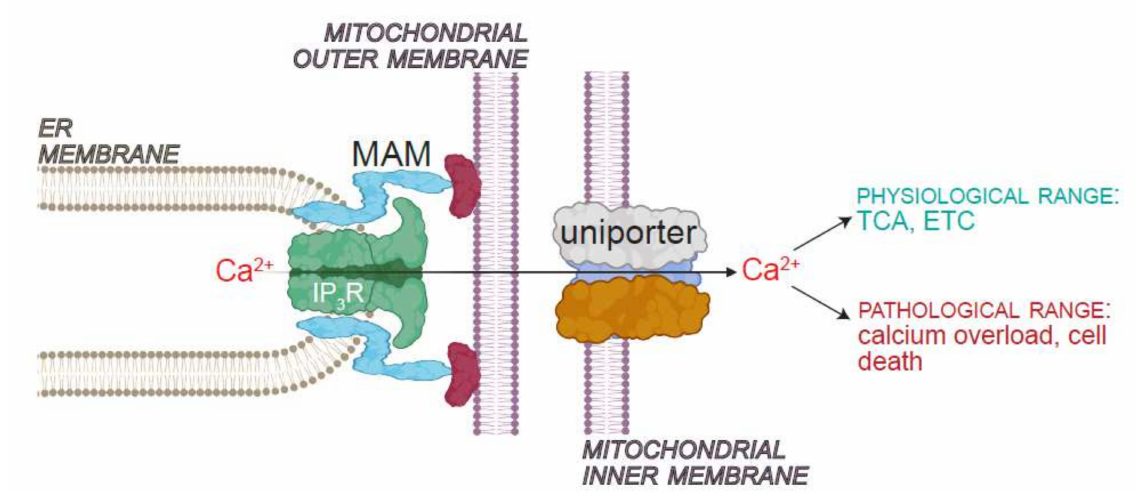
Figure 4. Interorganellar Ca 2+ transfer between ER and mitochondria. ER and mitochondrial outer membrane are physically tethered at sites called mitochondria associated membranes (MAMs). MAMs constitute the regions of metabolite exchange between the two organelles. A fraction of IP 3 Rs localize to MAMs, where they mediate the transfer of Ca 2+ from the ER lumen to the perimitochon- drial region. The mitochondrial Ca 2+ uniporter resides in the inner mitochondrial membrane, and is responsible for the transfer of Ca 2+ into the mitochondrial matrix. Physiological Ca 2+ elevations in the matrix are necessary for mitochondrial bioenergetics and the production of ATP via TCA and ETC. Ca 2+ overload, however, results in pathology and eventual cell death. Image created with BioRender.com (accessed 24 January